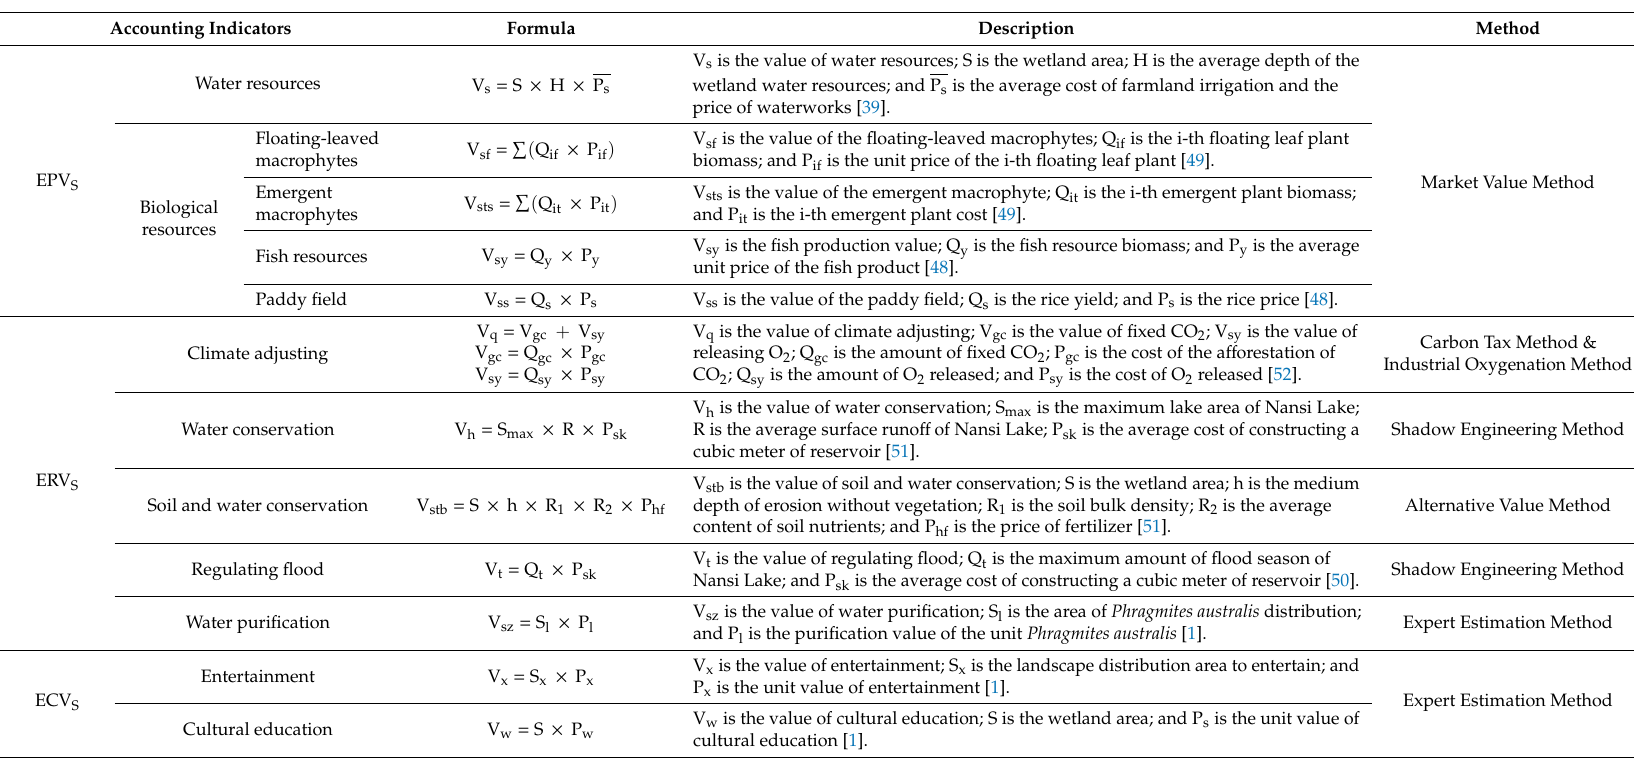
Table 1. Accounting indicators and formulas for the gross ecosystem product in the Nansi Lake Wetland 1